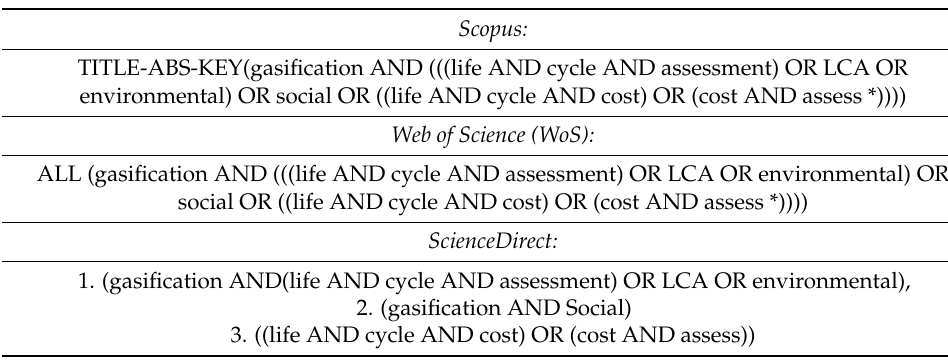
Figure 2. Overall research process scheme. Table 3. Initial strings used in databases.